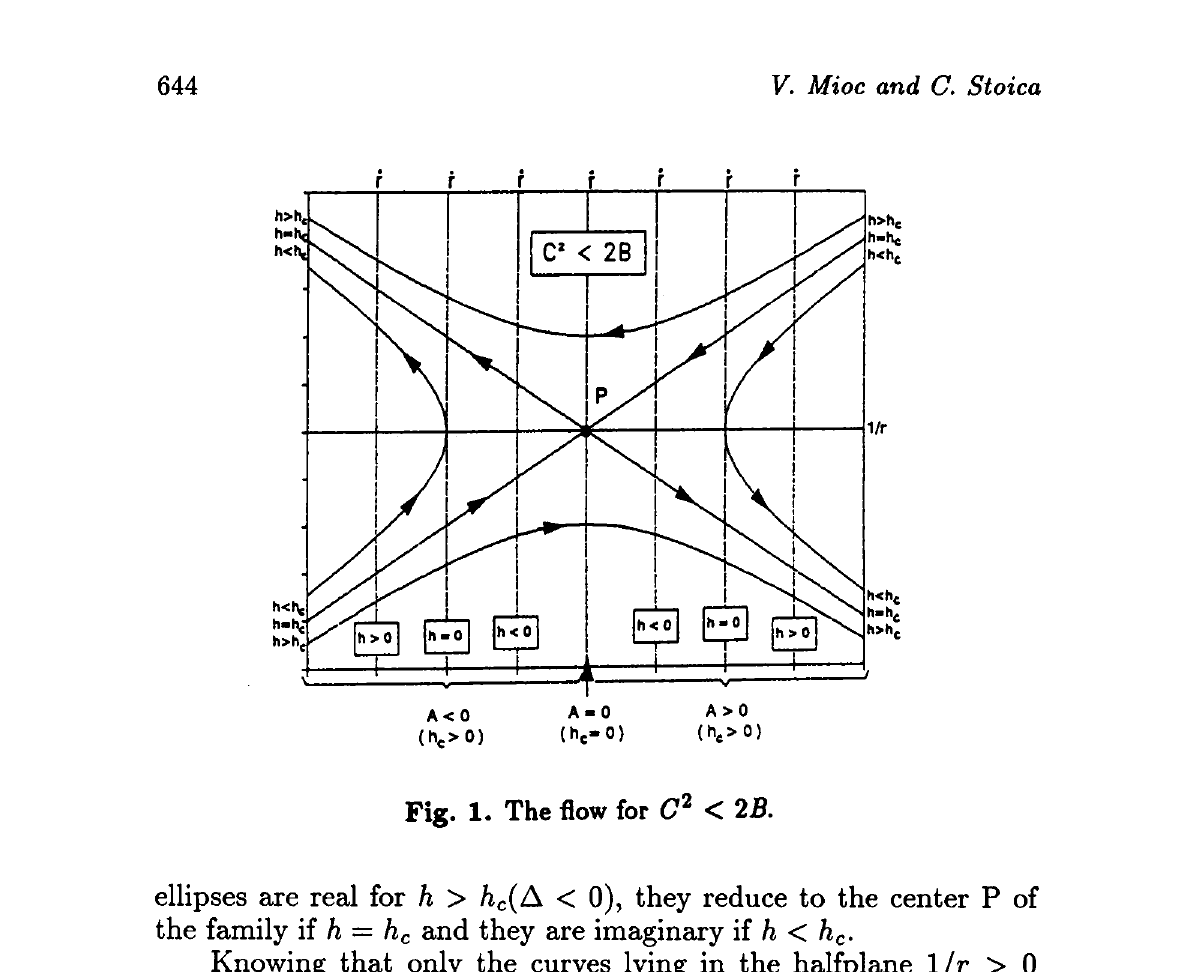
Fig. 1. The flow for C 2 <